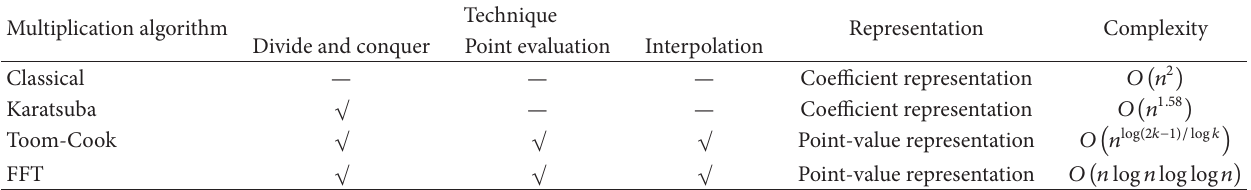
Table 1: Comparison of the well-known polynomial multiplication algorithms.